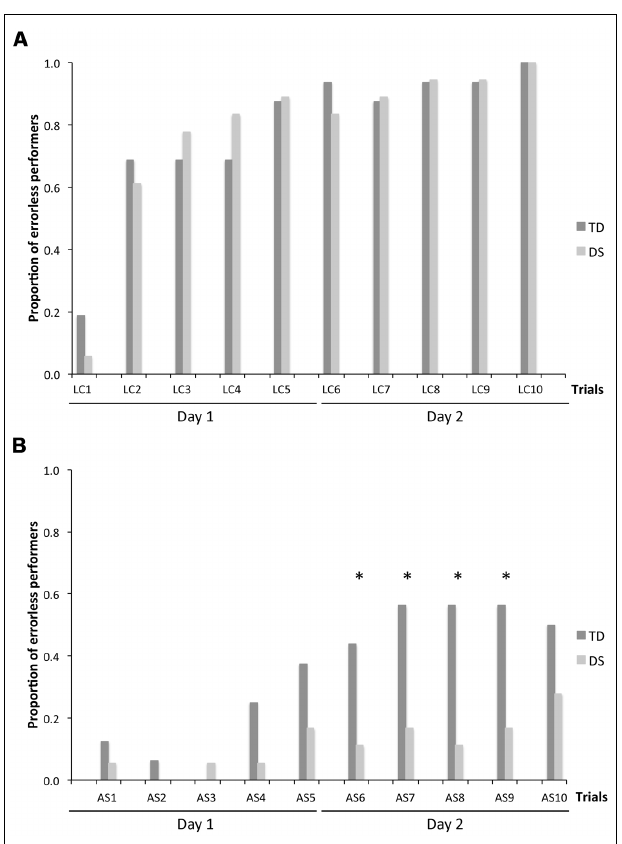
FIGURE 5 | Number of participants whose first choice was correct (FCC), expressed as a proportion of participants in each group: n = 16 forTD participants and n = 18 for participants with DS. (A) LC trials. (B) AS trials.The asterisks denote significant group differences on a given trial at p <